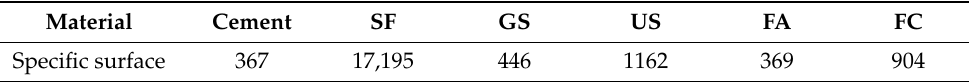
Table 3. Specific surface of cement and mineral admixtures (m 2 /kg).